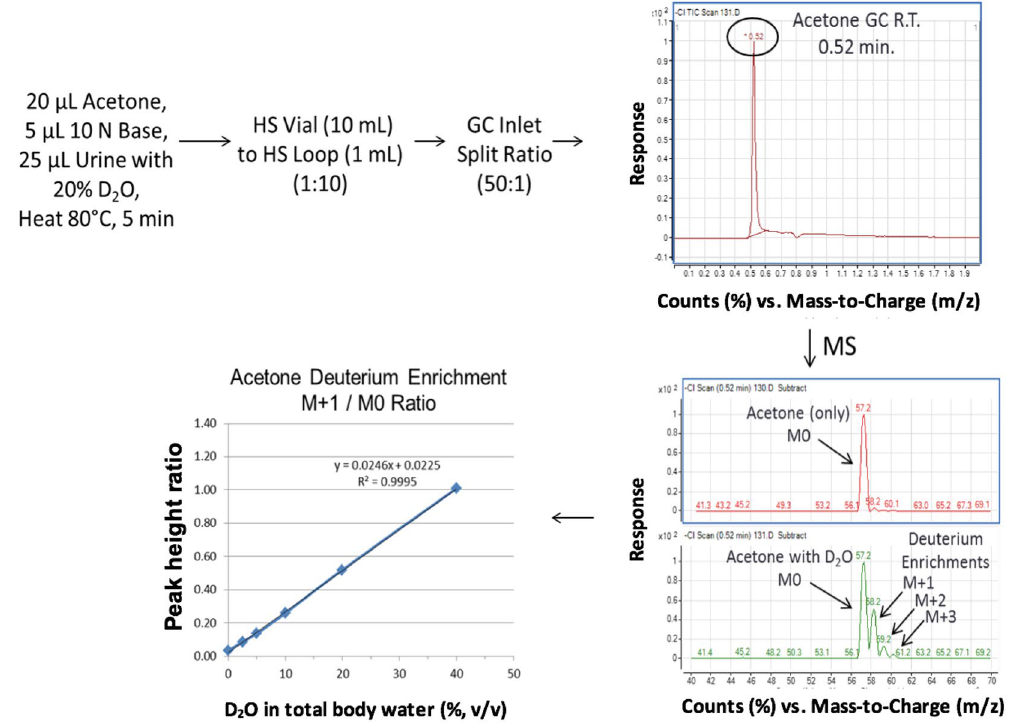
Figure 7. Test method diagram of rapid headspace-GC-NCI-MS full scan analysis with calibration curve of D 2 O in total body water (urine). Levels of D 2 O water (2–40%, v/v) in blank human urine were made basic (pH 13–14) using NaOH. Acetone was added, headspace vial capped and incubated using headspace method conditions (80 °C, 5 min) with analysis using headspace-GC-NCI-MS in full scan mode. Calibration curves were constructed using the acetone deuterium enrichment ratio (M + 1/M0) demonstrated good linearity (R 2 = 0.9995) from 2–40%,